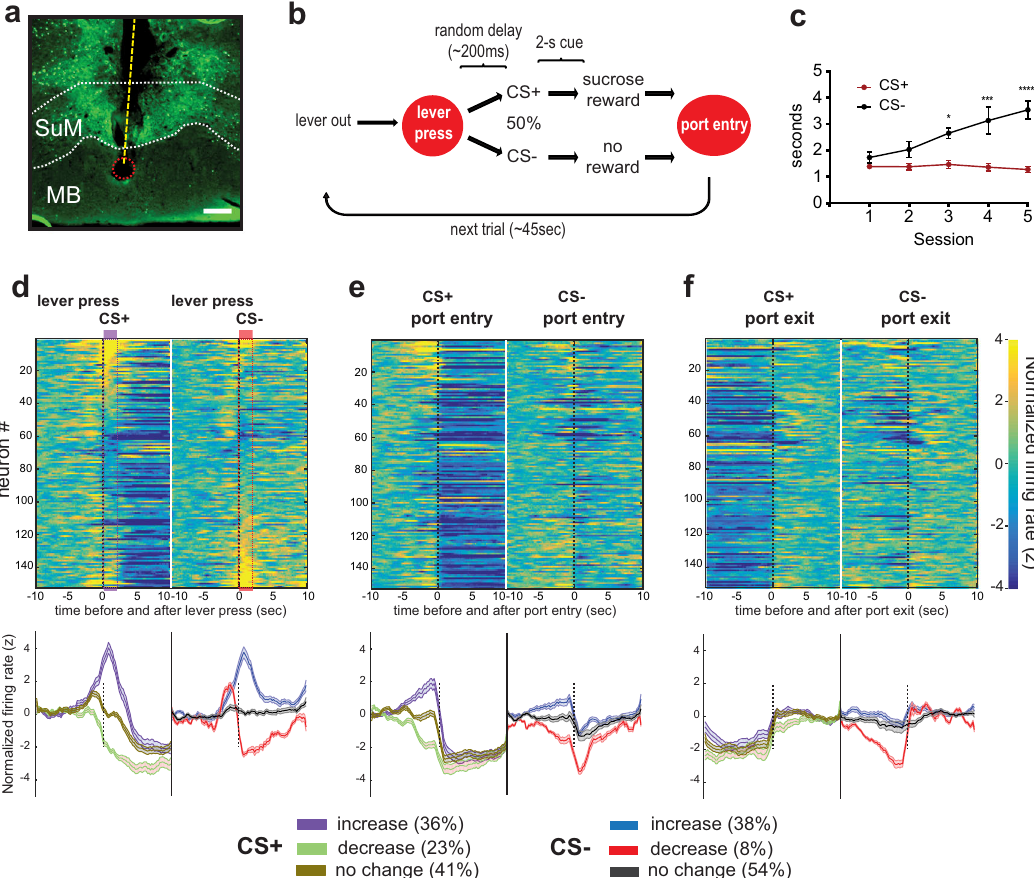
Fig. 5 Consummatory behavior decreases the activity of SuM neurons. a Example histology showing tetrode bundle track (dotted yellow line) passing through SuM with the tip marked by lesion (dotted red circle) ending in dorsal MB. Green fl uorescence is ChR2-eYFP expression. Scale bar = 200 µ m. b Diagram showing operant sucrose-seeking procedure with cue discrimination. c Latencies to enter sucrose port (mean ± SEM; n = 6 mice) after leaver pressing and hearing either CS + or CS − cues during training sessions. * p < 0.05, *** p < 0.001, **** p < 0.0001, Bonferroni test. d – f Top: Heatmaps of normalized fi ring rates of SuM neurons during lever presses that initiate CS + or CS − events ( d ), nose poke entry ( e ), and nose poke withdrawing ( f ) that follow CS + or CS − lever presses. Neurons are arranged in the same sequence from top to bottom across all heatmaps. Bottom: Traces indicate mean (±SEM) normalized fi ring rate of neurons that are categorized as increasing, decreasing, or non-responding to CS + and CS − with the same time scale as the raster plot above. The percentage of neurons in each category is shown in the boxes below. Source data are provided as a Source Data fi